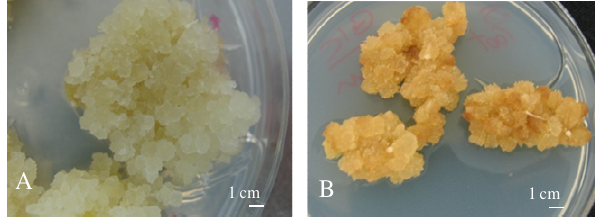
Fig. 12. Suspension culture of A. annua at first day (A), after a month (B), in medium containing 0.5 mg/L NAA and BAP